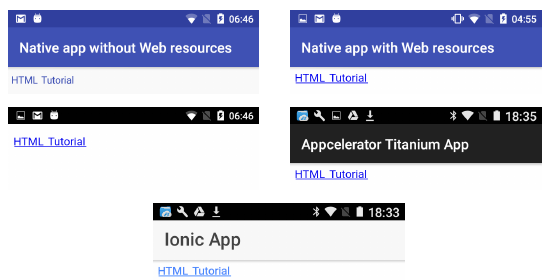
application (without Web resources), native application (with Web resources), Cordova application, Appcelerator application and Ionic application, respec-